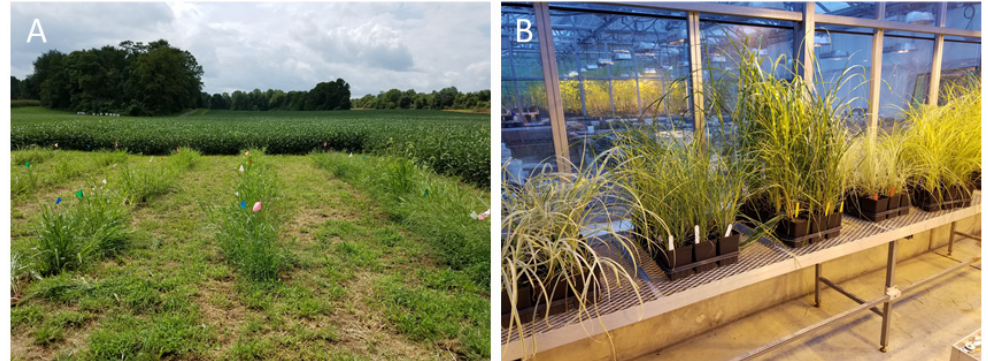
Figure 6. Miscanthus sinensis cultivars at the field site, two weeks after planting, and in the greenhouse. ( A ) the field site, M. sinensis cultivars during herbivory assays at the Western Maryland Research and Education Center (Keedysville, MD, USA); ( B ) M. sinensis cultivars I the greenhouse